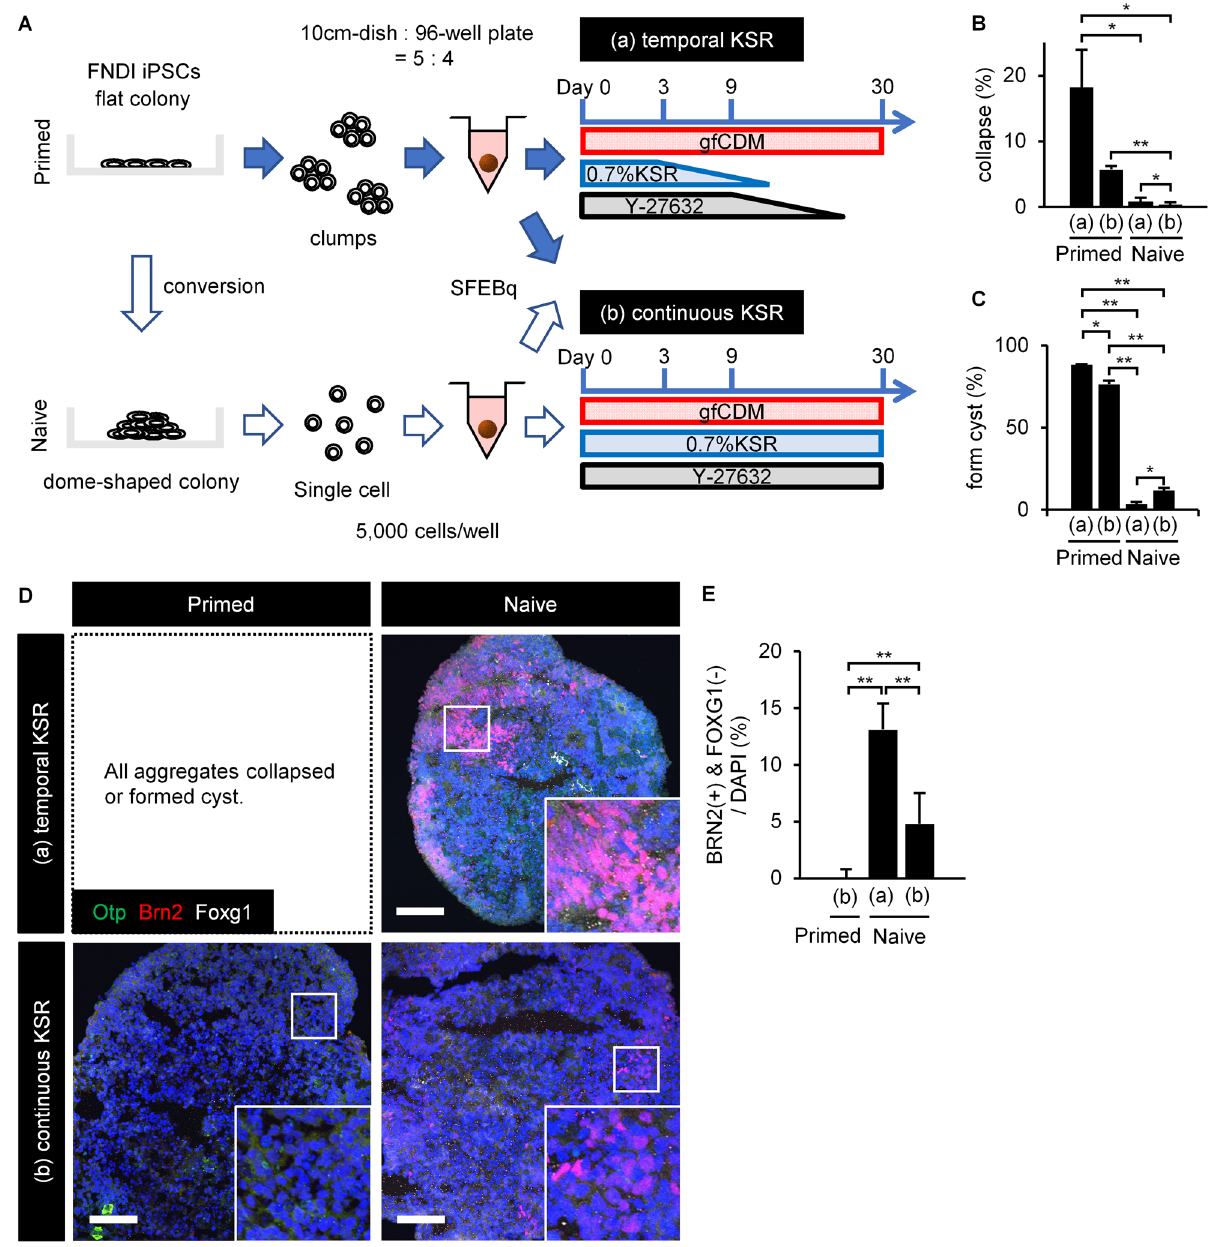
Figure 2. The partial conversion to the naive state showed improved aggregation on SFEBq and differentiation into hypothalamic-like cells. ( A ) Scheme of the culture protocol. Using a medium containing neither KSR nor Y-27632 from an early stage or a medium containing KSR and Y-27632 throughout, single naive hiPSCs (white arrows) were compared with primed hiPSC clumps (blue arrows). The (a) “temporal KSR” and (b) “continuous KSR” conditions were examined in both primed and naive cells. Under condition (a), KSR and Y-27632 were diluted stepwise by half medium change every 3 days with KSR(−)/Y-27632(+) medium after day 3 and KSR(−)/Y-27632(−) medium after day 9. ( B,C ) On day 30, naive aggregates showed significantly fewer changes, such as cyst formation or collapse (n = 3; three 96-well plates, that is, 288 aggregates are analyzed). Mean ± SEM. *P < 0.05; **P < 0.01, two-tailed unpaired t -test. On day 30, primed aggregates scarcely expressed BRN2; however, BRN2 expression was observed by conversion to the naive state ( D ), and was significantly increased by shortening the period of KSR and Y-27632 treatment (n = 8) ( E ). Mean ± SEM. *P < 0.05, **P < 0.01, two-tailed unpaired t -test. OTP (green), BRN2 (red), FOXG1 (white). The increased expression of the AVP precursor marker, BRN2, indicated that minimization of exogenous signals improved the efficiency of differentiation into hypothalamic-like cells. For all relevant panels, nuclear counterstaining was performed with DAPI (blue). Scale bars, 100